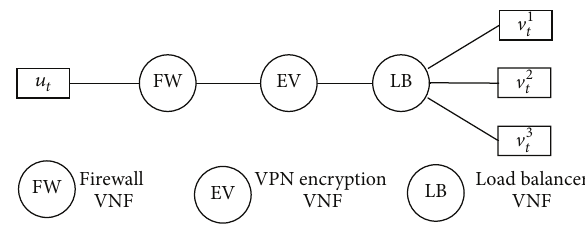
Figure 6: An example of SFC composed of one firewall VNF, one VPN encryption VNF, and one load balancer VNF that splits the input traffic towards three output logical links. 𝑢 𝑡 denotes the ingress access node while V 1 𝑡 , V 2 𝑡 , and V 3 𝑡 denote the egress access nodes.